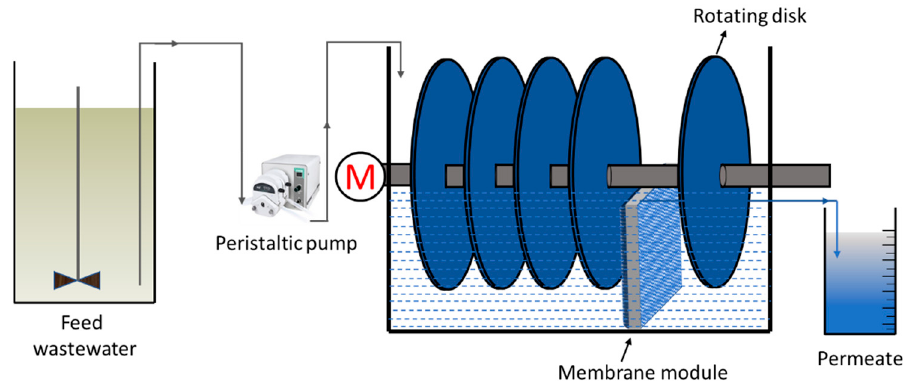
Figure 1. Schematic diagram of RBC-ME configuration.